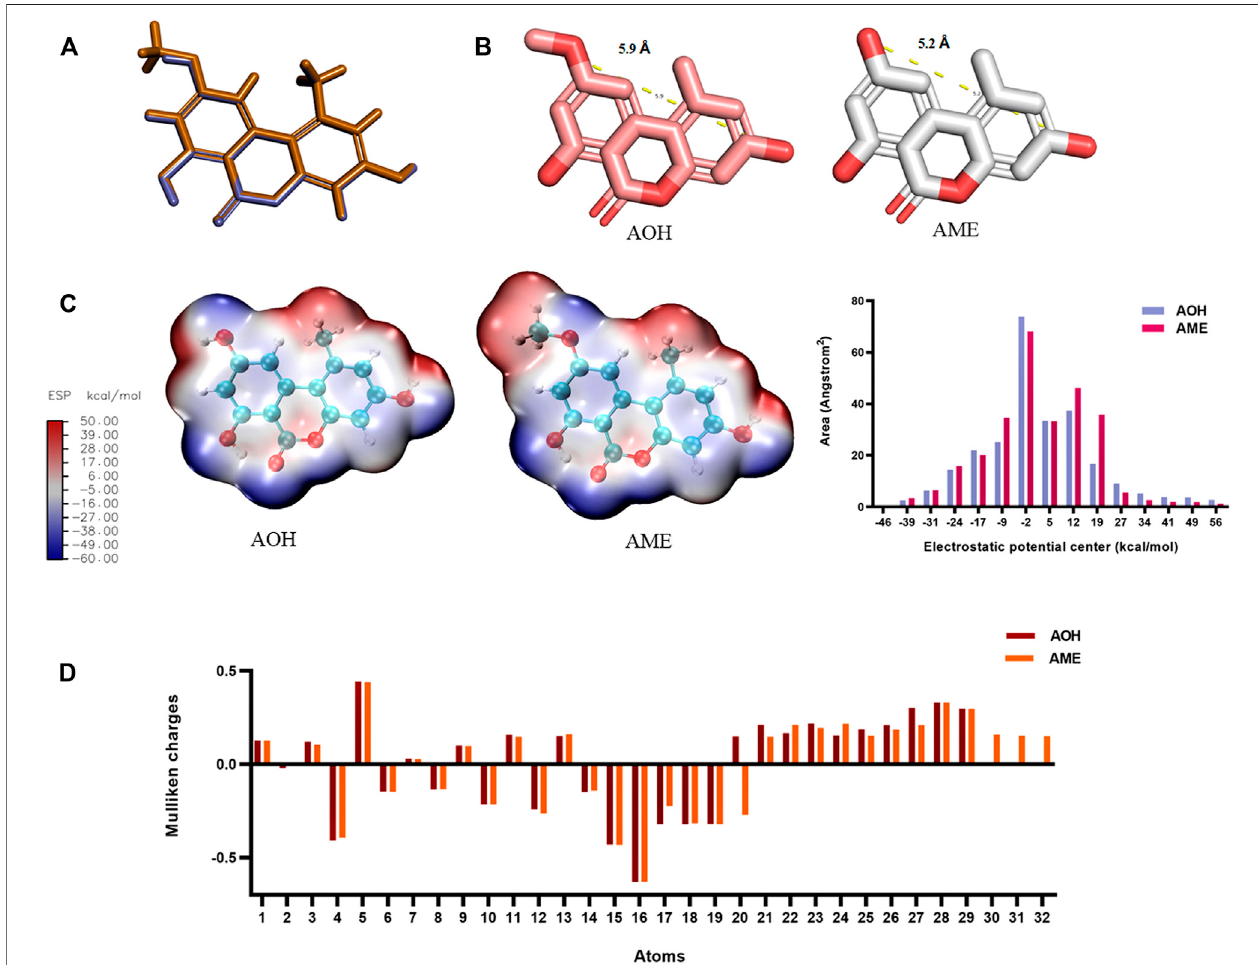
FIGURE2| StructuralanalysisofAOH andAME. (A) Molecular overlay (purple representsAOHand yellow represents AME). (B) Molecular scaleofAOH andAME. (C) ESP of AOH and AME. (D) Mulliken charge of AOH and AME.